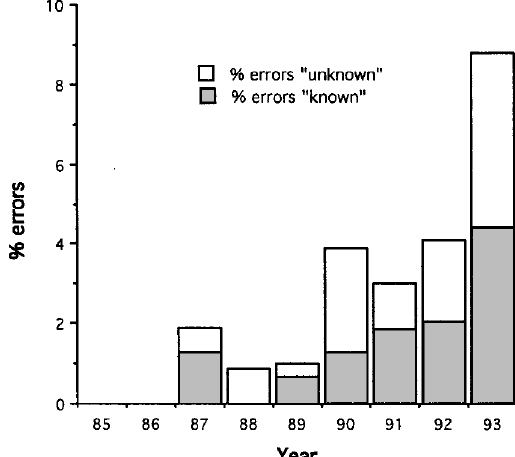
Fig. 1. Graphic representation of the percentage of errors per year over the 8 years of this review. The percentage errors already ‘known’ are shown shaded whilst those errors revealed by this enquiry are